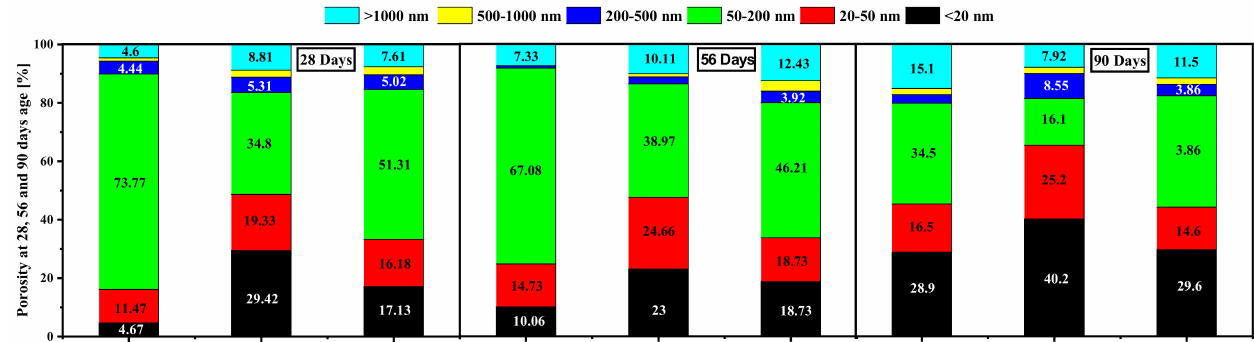
Figure 14. Distribution of porosities.